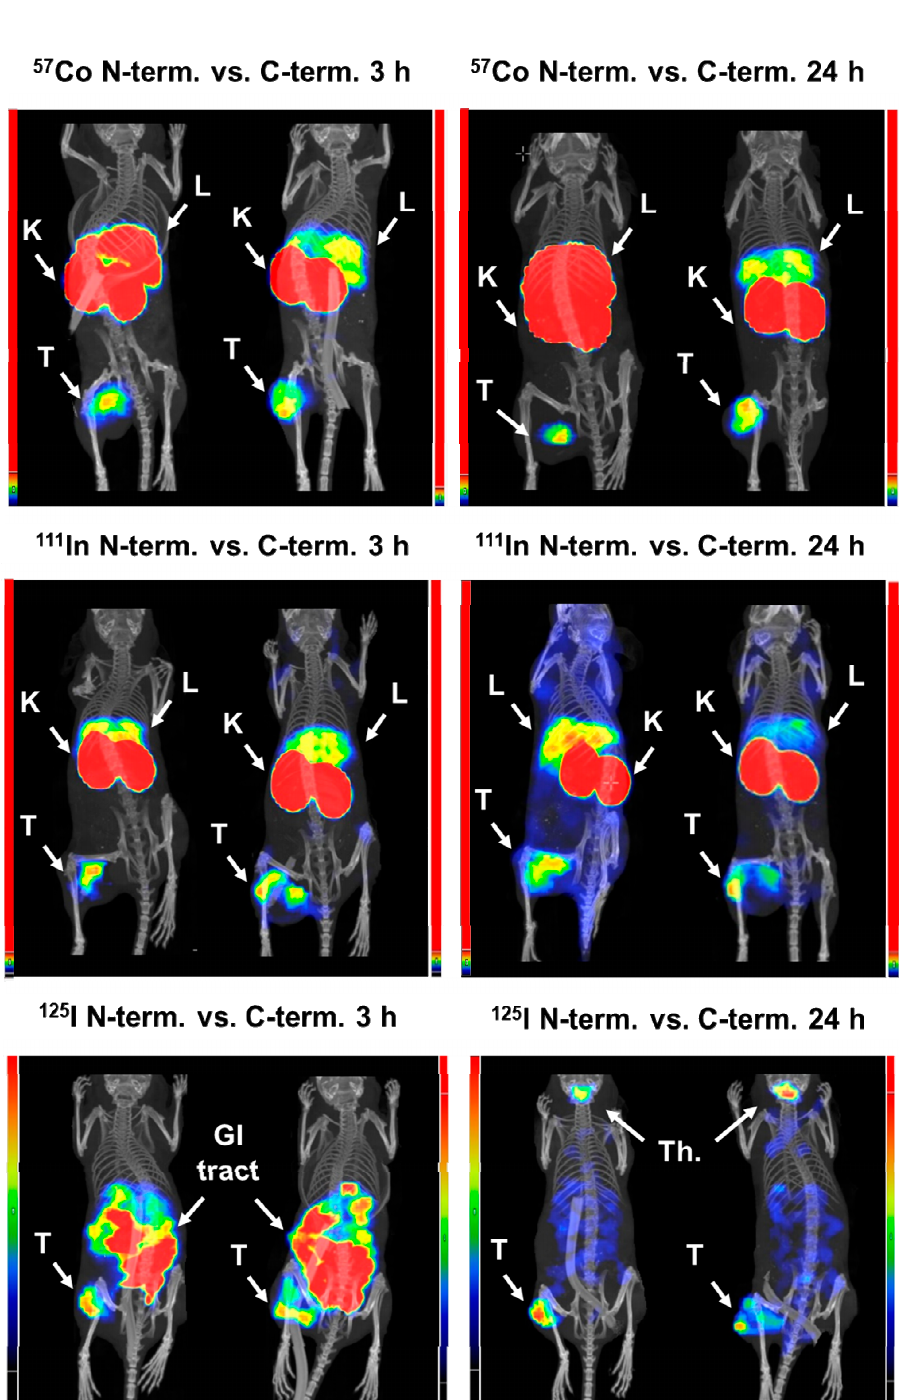
Figure 7. Micro-Single-Photon Emission Computed Tomography/Computed Tomography (microSPECT/CT) imaging of EpCAM expression in Balb/c nu/nu mice bearing EpCAM-expressing DU145 xenografts at 3 and 24 h post injection (p.i.). Ec1 variants labeled with [ 57 Co]Co, [ 111 In]In and [ 125 I]I-HPEM at N- or C-terminus. Arrows indicate: T—tumor, K—kidneys, L—liver, Th.—thyroid. The relative color scales are adjusted to the first red pixel in the tumor. Left scales are related to imaging using variants with a label on the N-terminus and right scales to imaging using variants with a label on the C-terminus.